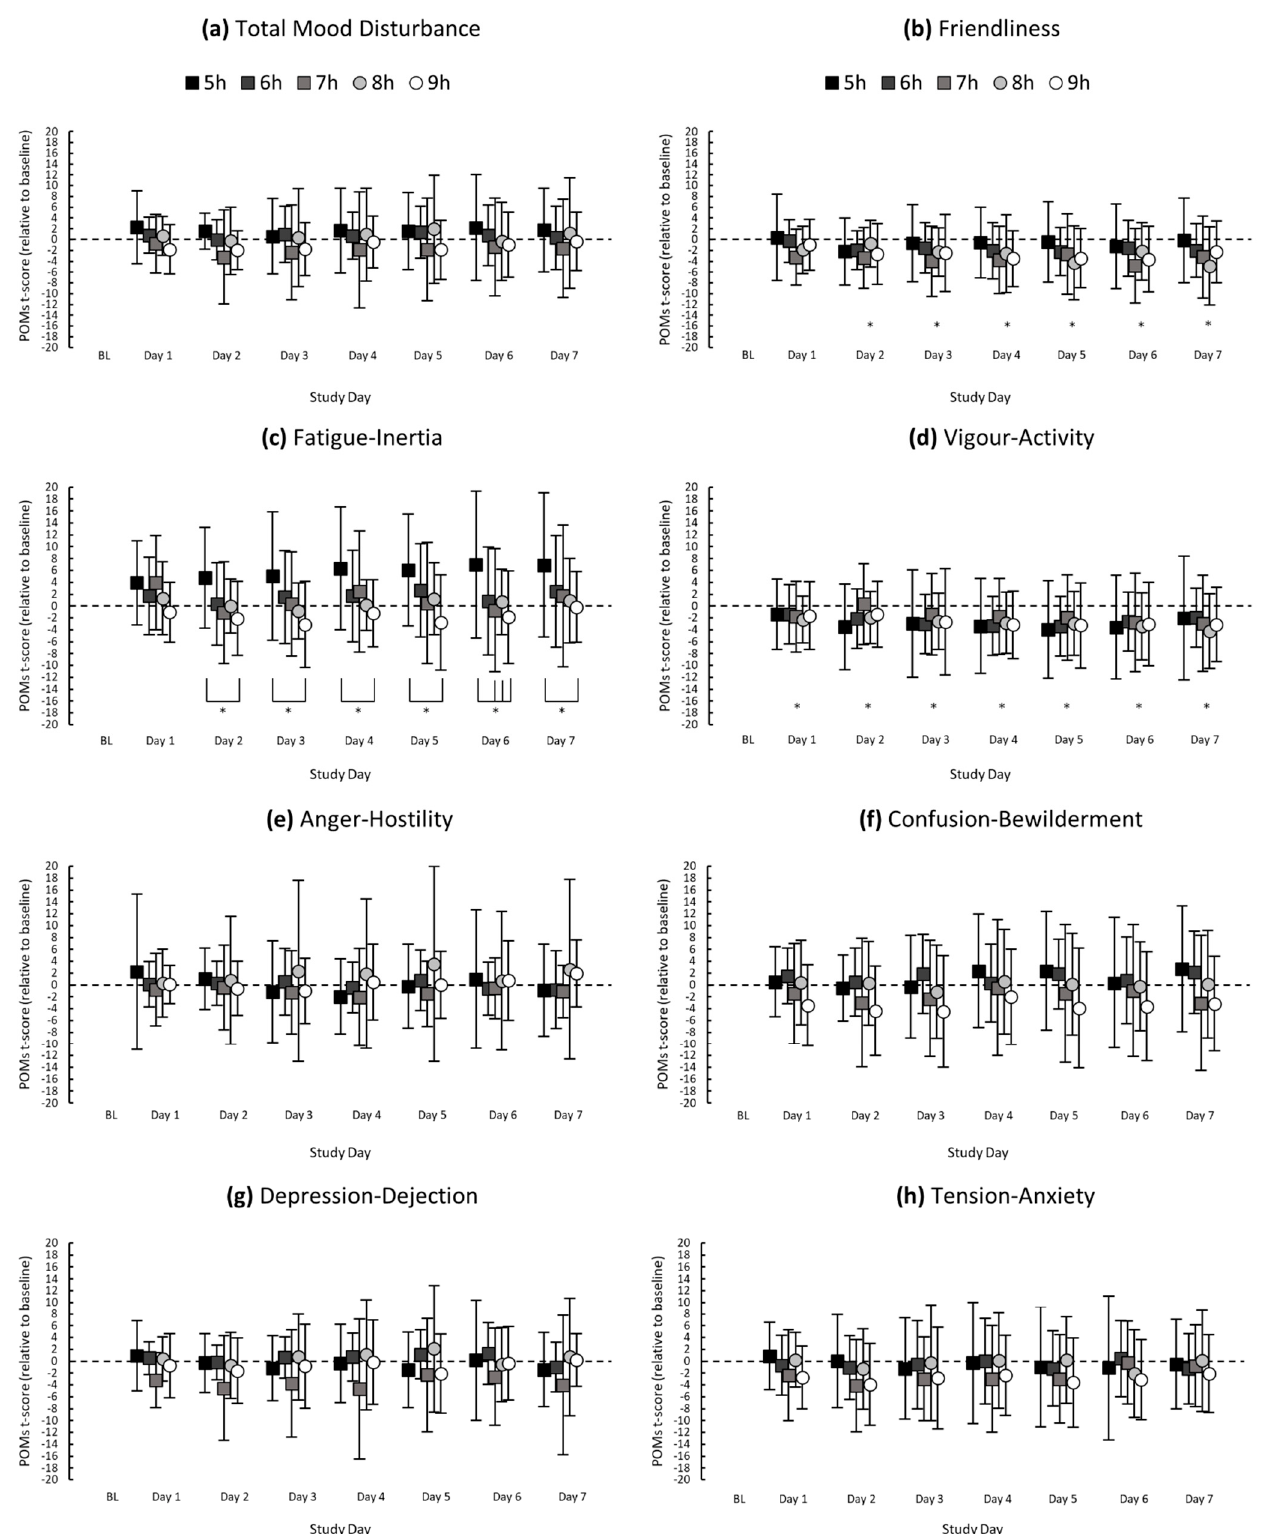
Figure 1. Mean POMs t-scores (relative to baseline) of ( a ) Total Mood Disturbance, ( b ) Friendliness, ( c ) Fatigue-Inertia, ( d ) Vigour-Activity, ( e ) Anger-Hostility, ( f ) Confusion-Bewilderment, ( g ) Depression-Dejection and ( h ) Tension-Anxiety for each study day. Asterisks (*) indicate a significant difference between study day and baseline; asterisks with brackets indicate a significant difference between sleep groups on the respective study day. Error bars represent standard deviations from the means.